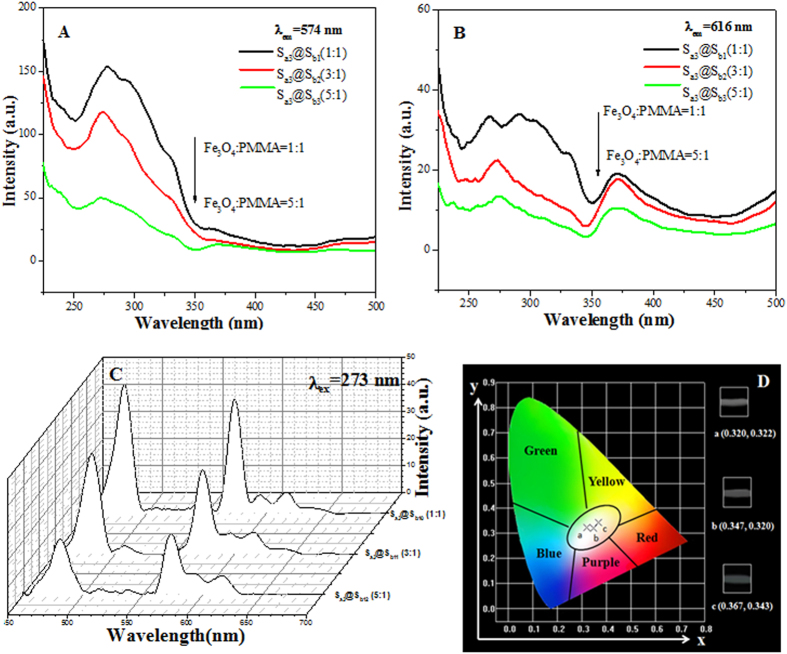
Excitation spectra (A,B), emission spectra (C) and CIE chromaticity coordinate diagram (D) of [Fe3O4/PMMA]@{[Dy(BA)3phen+Eu(BA)3phen]/PANI/PMMA} coaxial nanoribbons containing different mass percentages of Fe3O4.